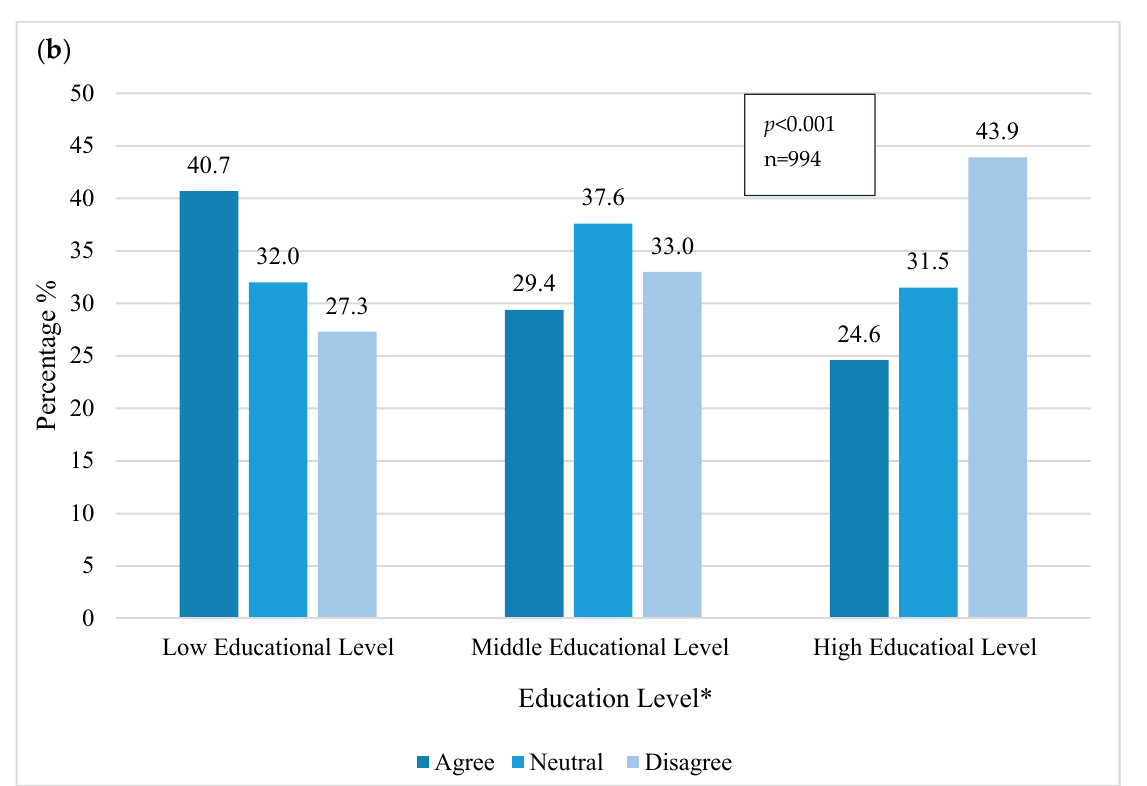
Figure 5. Availability of information regarding the impact of plastic on human health considering ( a ) gender and ( b ) education. * Significant relation (chi2, p = 0.036) between gender and opinion on available information. * Significant relation (chi2, p < 0.001) between education levels and opinion on available information.